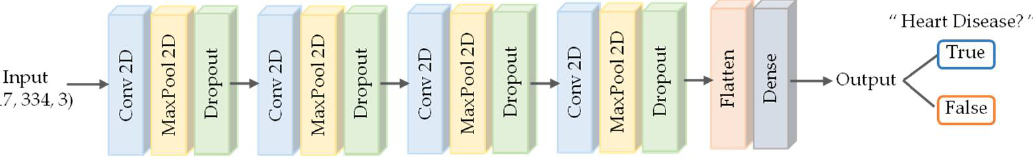
Figure 8. Our CNN architecture.